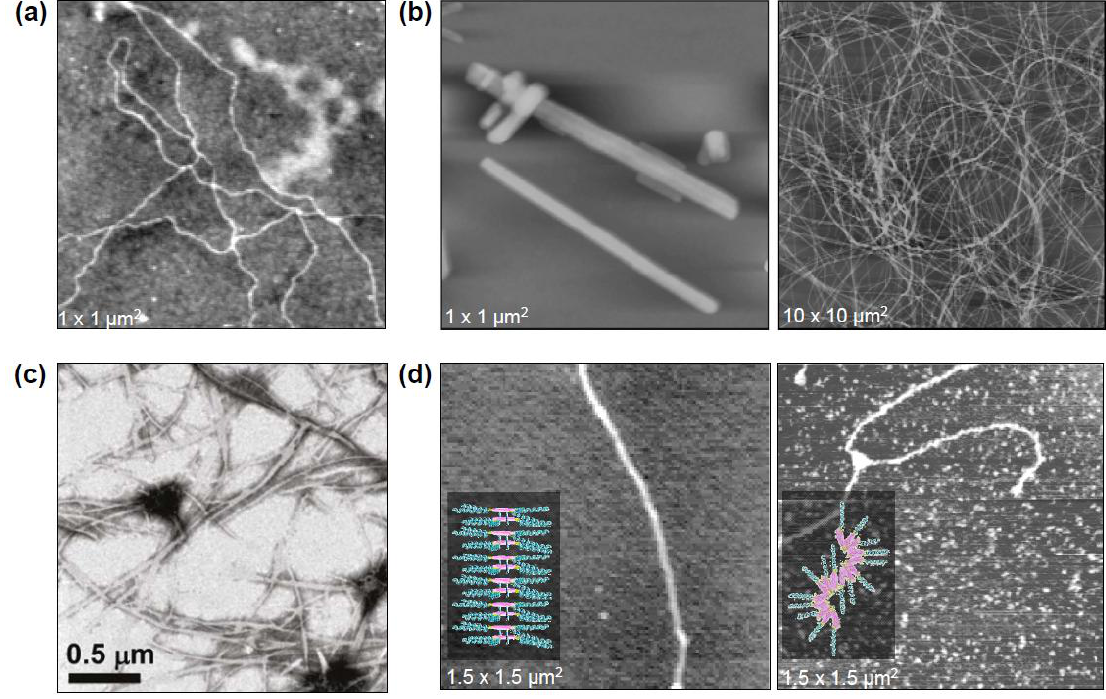
Figure 7. Scanning force height images (a, b, d) and transmission electron micrograph (c) of collapsed/dried samples of ( a ) poly[2-(4-(  - D -glucosylsulfanyl)-butyl)-2-oxazoline] 126 nanotubes [97], ( b ) crystalline PiPrOx nanoribbons/nanofibers [98], reproduced by 47 permission of Wiley-VCH, ( c ) C18-PiPrOx microfibers [99], reproduced by permission of the American Chemical Society, and ( d ) stacks/wires of star- (left) and tadpole-shaped (right) PMeOx-triphenylene [100], reproduced by permission of the American Chemical